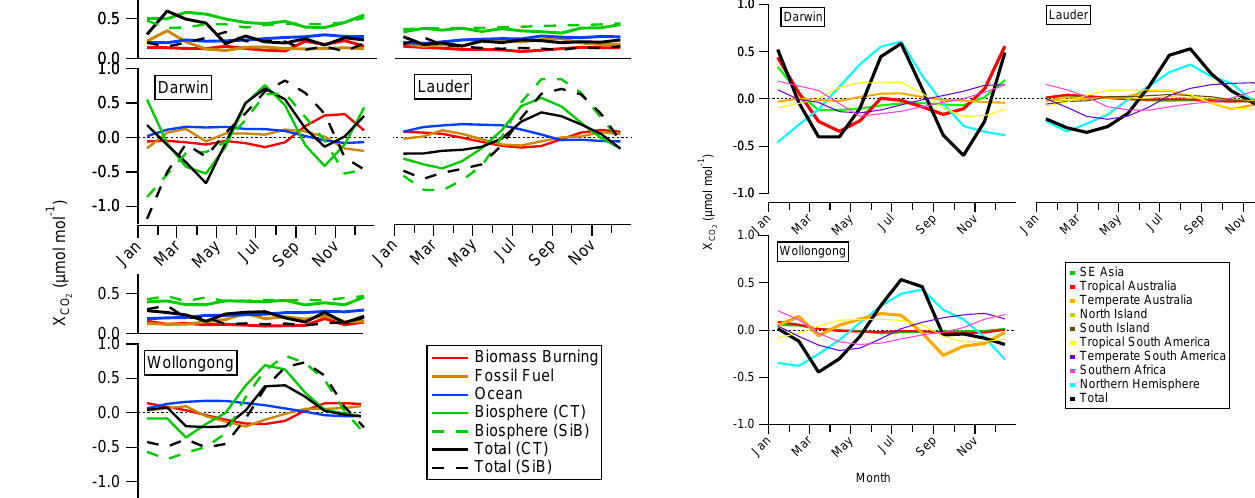
Figure 5. Regional decomposition of the mean seasonal cycles of the terrestrial biosphere in the TM3 simulation with CT2011_oi